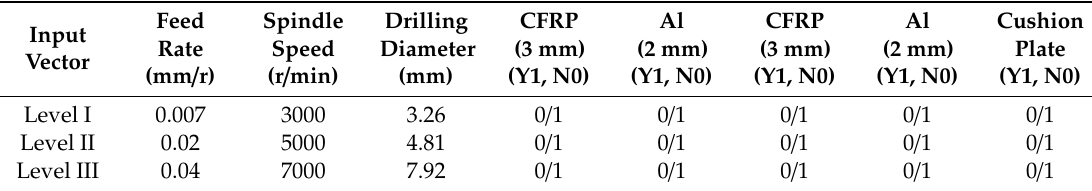
Table 4. Input vector level.